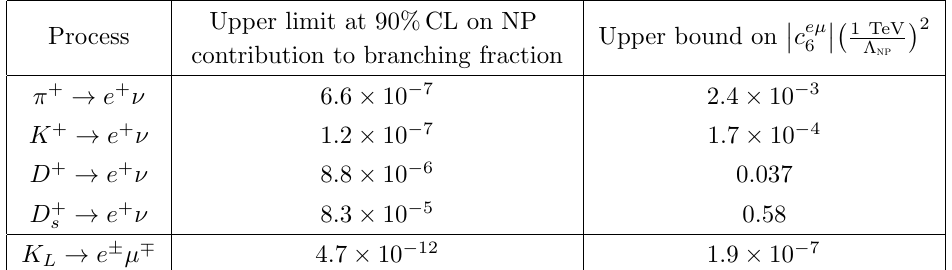
Table 2 . Bounds on coe(cid:14)cients of scalar operators Q ‘‘ 0